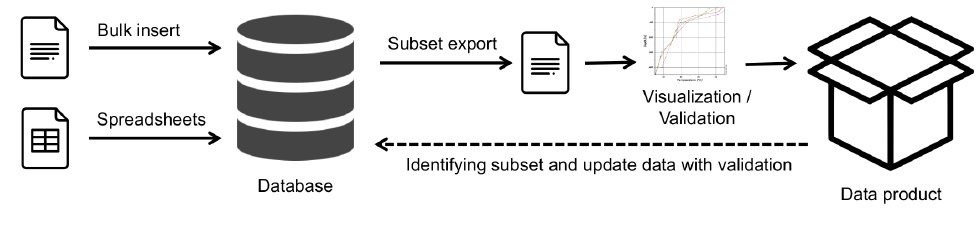
Figure 1. Schematic view of traditional “one direction” data